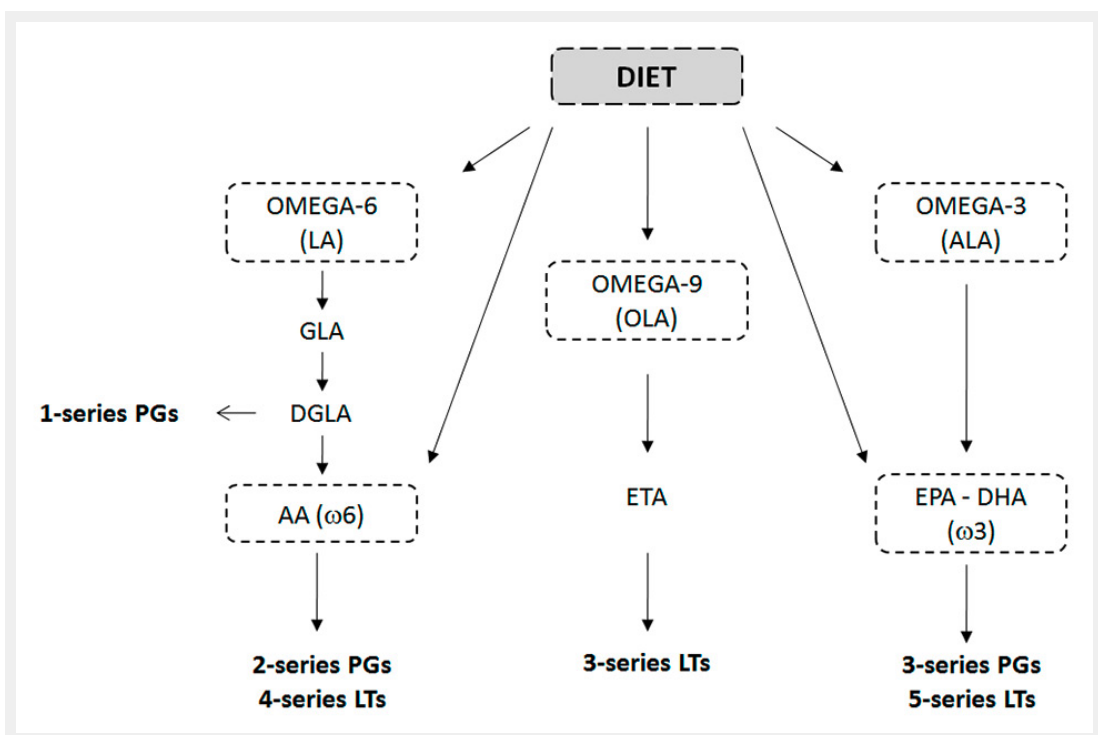
Figure 3 The influence of diet on prostaglandin and leukotriene production from polyunsaturated n-3 and n-6 fatty acids and monounsaturated n-9 fatty acids. AA = arachidonic acid; ALA = α-linolenic acid; DGLA = dihomo-γ-linolenic acid; DHA = docosahexaenoic acid; DPA = docosapentaenoic acid; EPA = eicosapentaenoic acid; ETA = eicosatrienoic acid; GLA = γ-linolenic acid; LA = linoleic acid; LTs = leukotrienes; PGs =